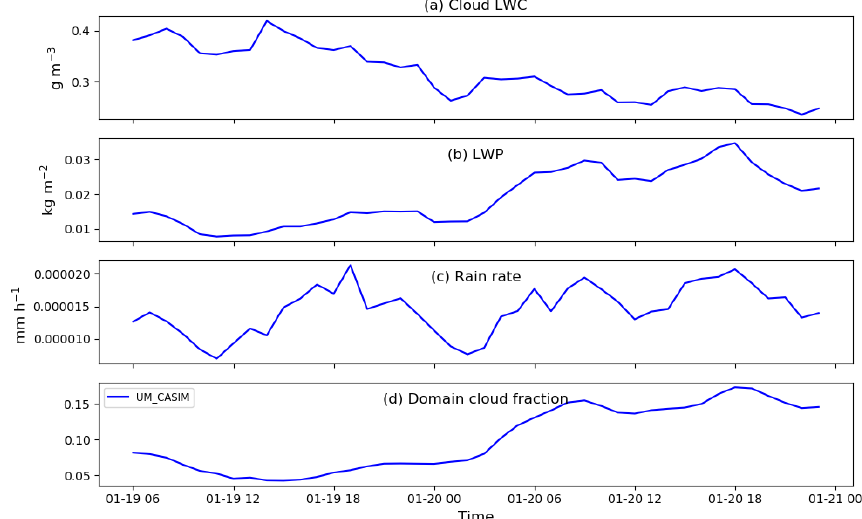
Figure 2. Time series of domain-averaged (a) cloud liquid water content (in-cloud only), (b) liquid water path, (c) rain rate, and (d) cloud fraction, all for the baseline case UM_CASIM. A liquid water content threshold of 0.01gm − 3 is used to define a cloudy grid box.